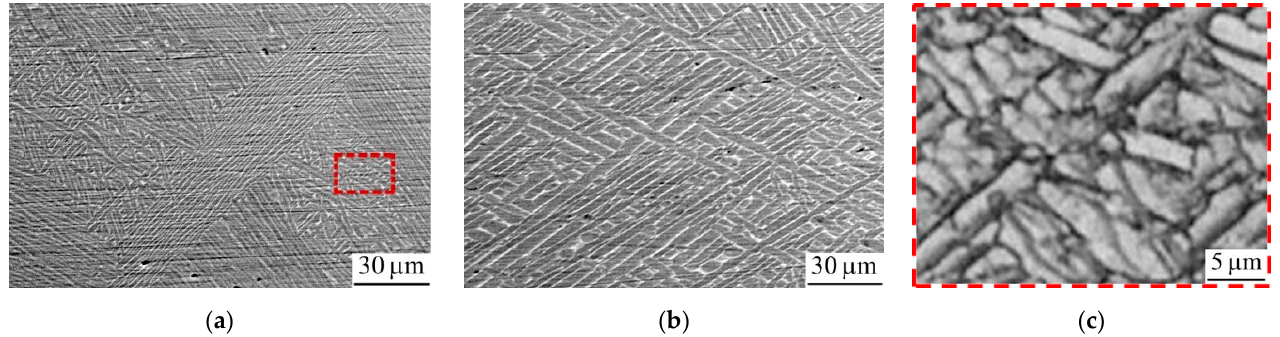
Figure 3. SEM ( a , b ) and optical micrographs ( c ) of the microstructure of the EBAM Ti-6Al-4V samples produced without substrate cooling. The dashed red line box in ( a ) highlights the area that is enlarged in ( c ). The microstructure was obtained at a distance of 40 mm from the substrate.